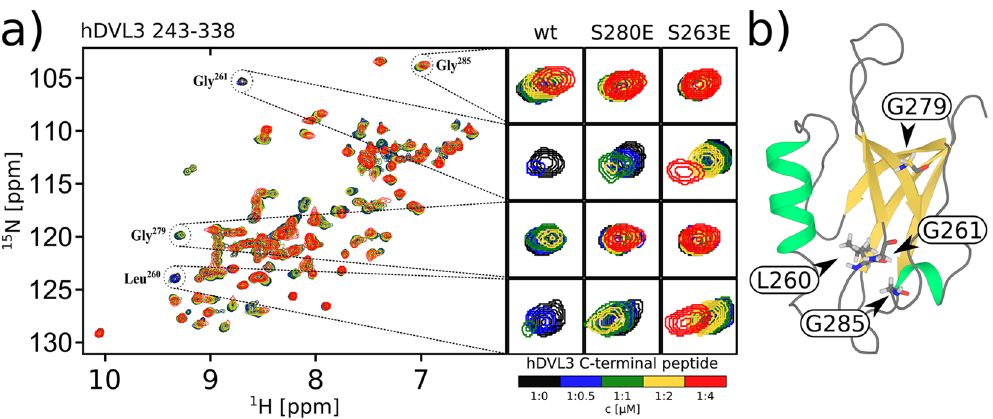
1 H 15 N Figure 7. The NMR titration. ( a ) Overlay of – HSQC spectra from NMR titration of the PDZ domain (243–338) from human DVL3 by C-terminal peptide (698–716) (see “Materials and methods” section). Spectra with increasing concentration of the C-terminal peptide are colored from black (no peptide) to red (four-time higher concentration of peptide with respect to PDZ). Peaks that report PDZ-peptide interaction are highlighted with circles. Changes in peak intensity for each reporter residues in mutants S280E and S263E are emphasized on the side. ( b ) Position of reporter residues in the PDZ